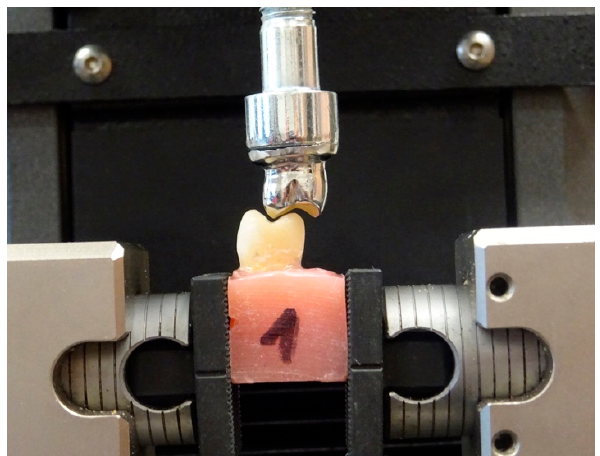
Figure 2. A root covered with a layer of silicone.